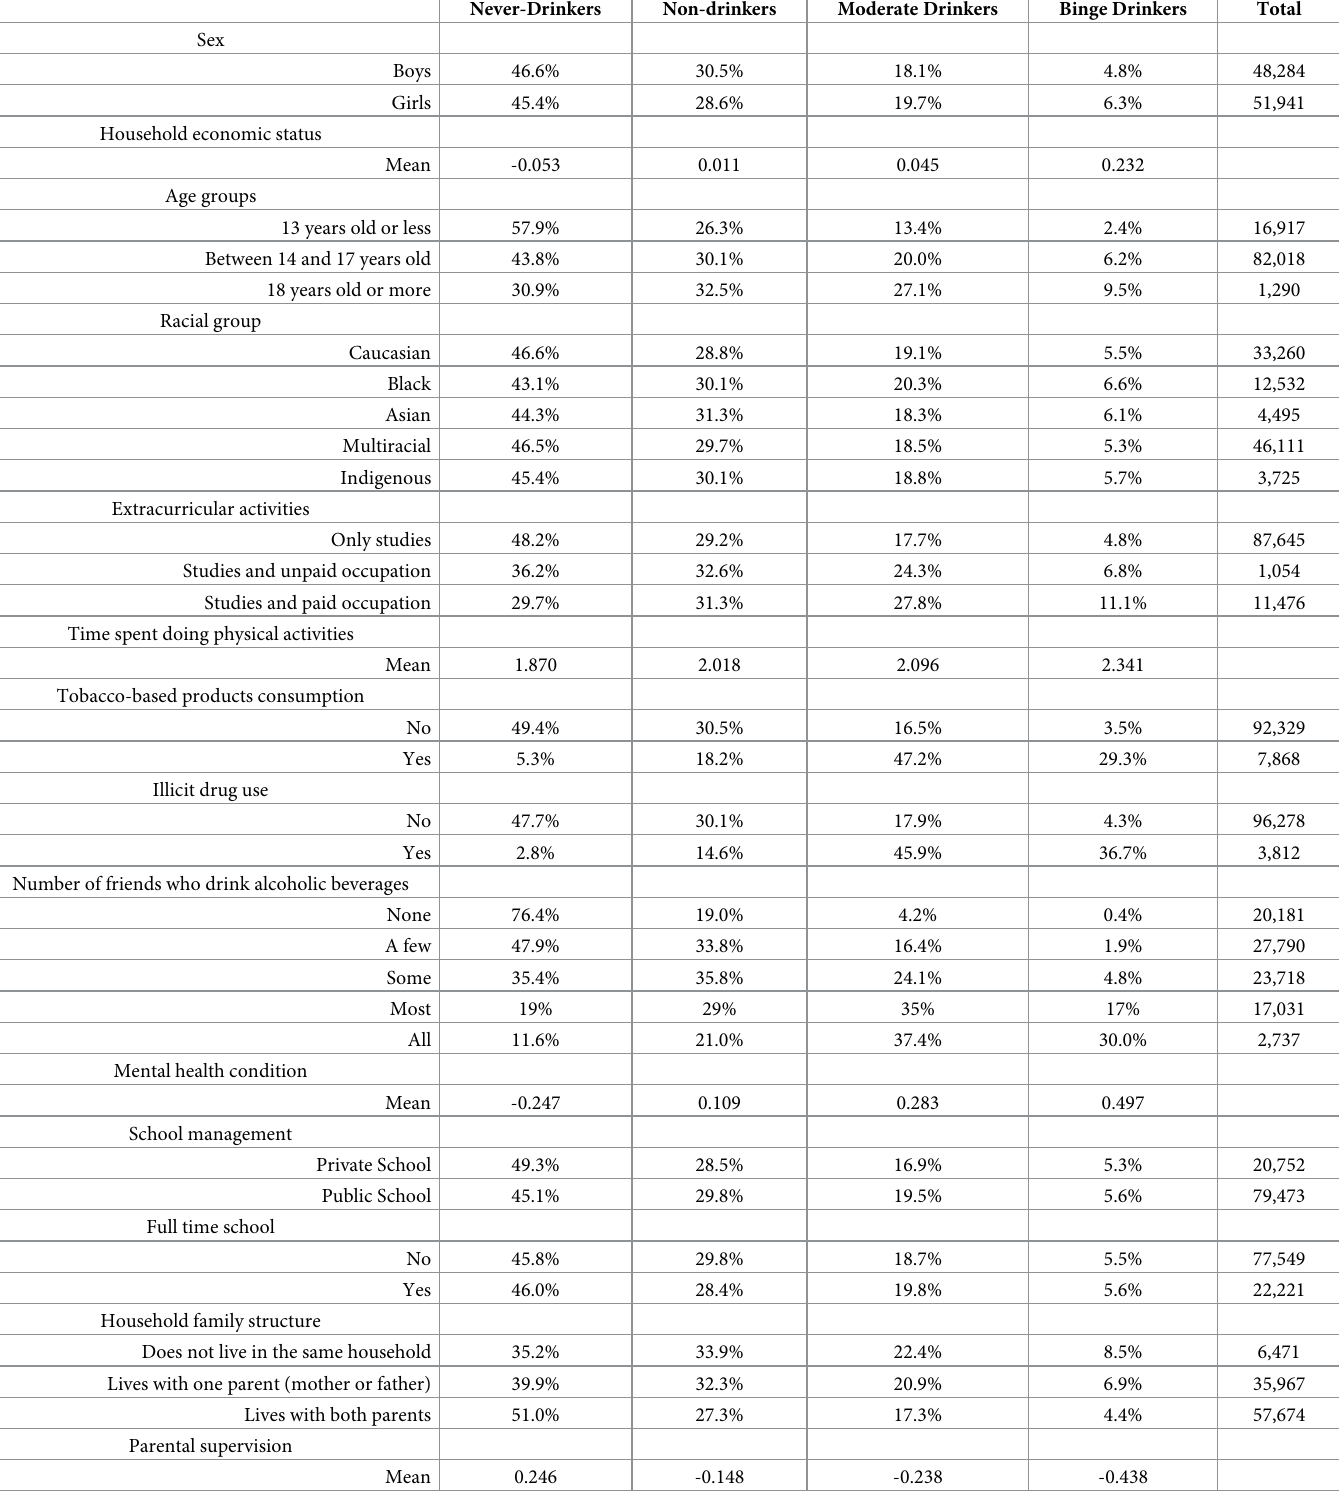
Table 1. Description of the sample by alcohol consumption